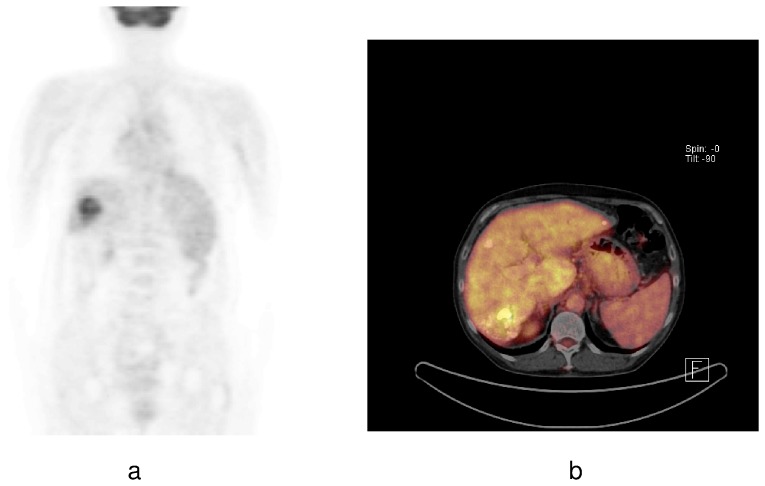
HCC with increased 18F-FDG uptake on a pretransplant PET scan and b PET-CT scan were classified as PET +.